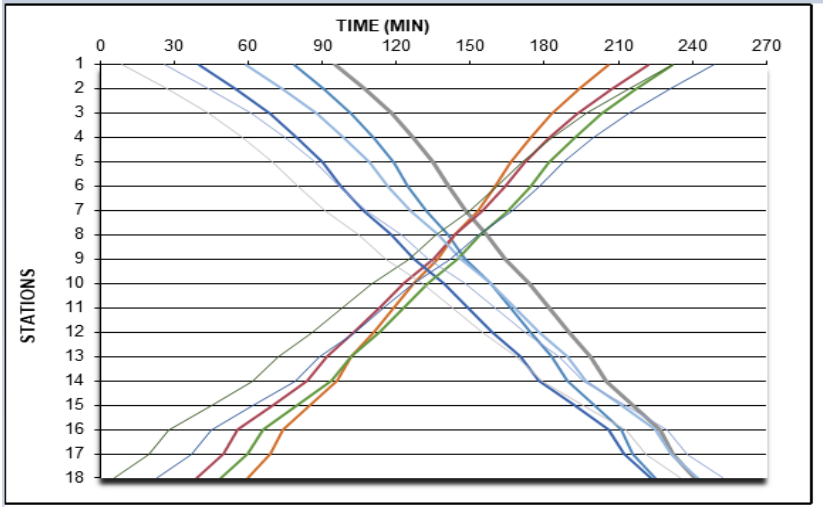
Figure 5. Initial (infeasible) state of Instance 1.